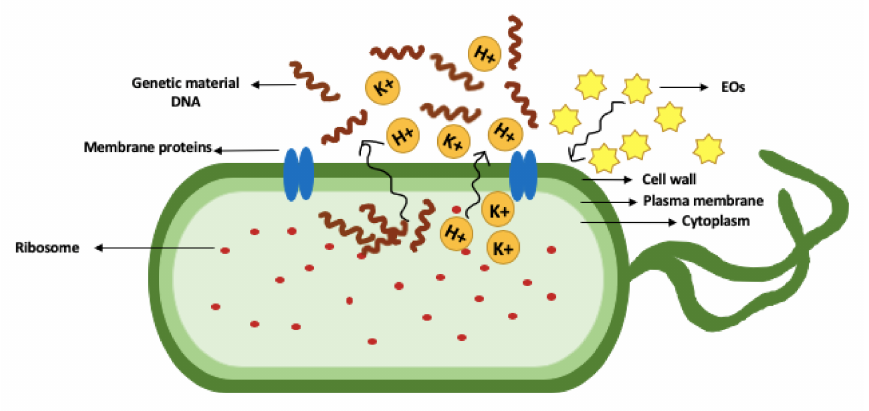
Figure 2. Increased membrane permeability and leakage of cell contents in a bacterial cell. K+ is potassium ion and H+ is hydrogen